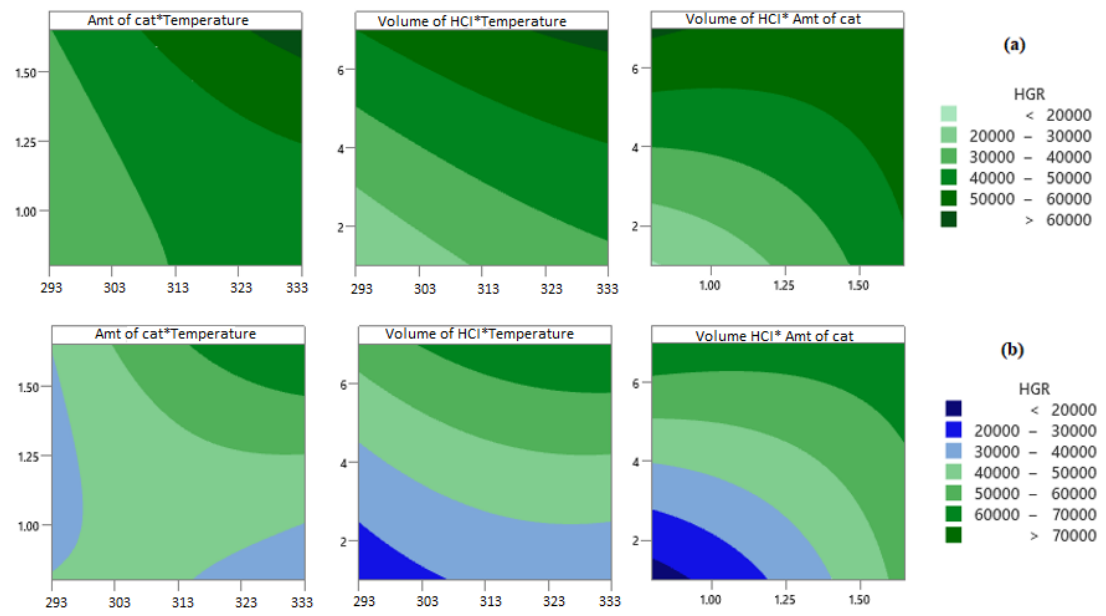
Figure 6. Contour plots of HGR for ( a ) NiCr system and ( b ) NiV system.